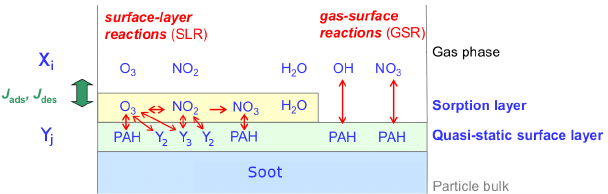
Fig. 1. Illustration of the PRA framework as used in this study (adapted from Shiraiwa et al., 2009). Fluxes of volatile species X i (O 3 , NO 2 , H 2 O, OH, and NO 3 ) are indicated by the green arrow, reactions by the red arrows. The soot particles are coated with a monolayer of non-volatile species Y j (only the reactive ones, PAH, Y2, and Y3, are shown